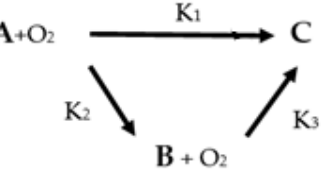
Figure 6. A two-stage oxidation mechanism according to Li et al. [59].